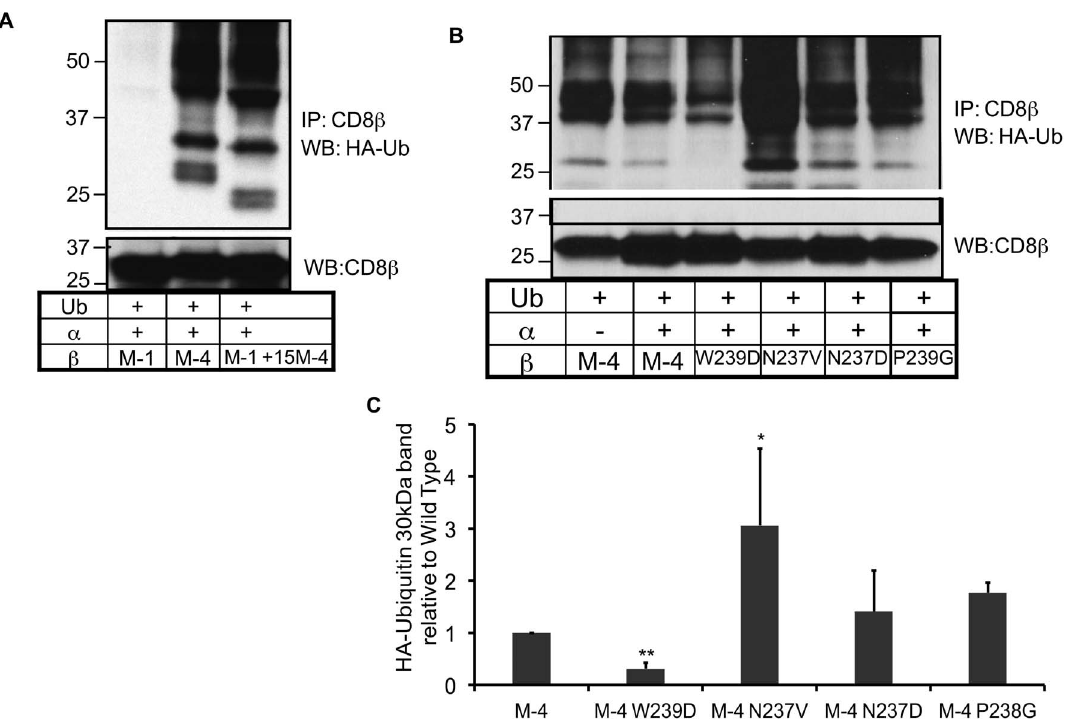
Figure 5. The NPW motif in the M-4 cytoplasmic tail mediates binding to ubiquitinated proteins. ( A ) HEK-293T cells co-transfected with plasmids expressing HA-tagged ubiquitin, and CD8 b wild type M1, M4 or chimeric protein M1 with 15 amino acids of the C terminus of the M4 cytoplasmic tail. After 48 hrs cells were lysed with 1% BRIJ 97, precipitated with anti-CD8 b mAb and run on a polyacrylamide gel. Western blotting was performed with the indicated antibody. The membrane was then stripped and re-probed with the anti-CD8 b antibody. The experiment was repeated three times. ( B ) HEK-293T cells co-transfected with plasmids expressing HA-tagged ubiquitin, and CD8 b wild type or mutant proteins. The immunoprecipitation and Western blotting experiments were performed as in (A). A representative of four experiments is depicted. ( C ) The intensity of the 30 kDa band was analyzed and the amount of the 30 kDa band of the wild type relative to each mutant protein is represented. The levels of CD8 b protein detected after reprobing with anti-CD8 b antibody were used to correct for differences in protein expression between experiments. Student’s paired t-test was used to determine statistical differences of the mutants relative to the wild type M-4 isoform, indicated as one star * for p ,